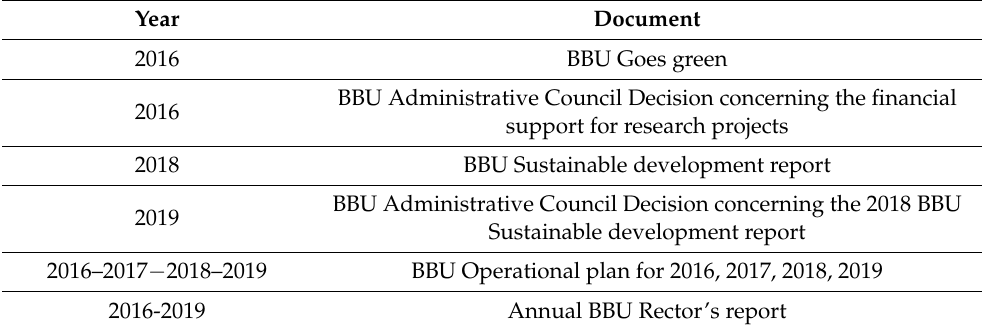
Table 1. Analyzed